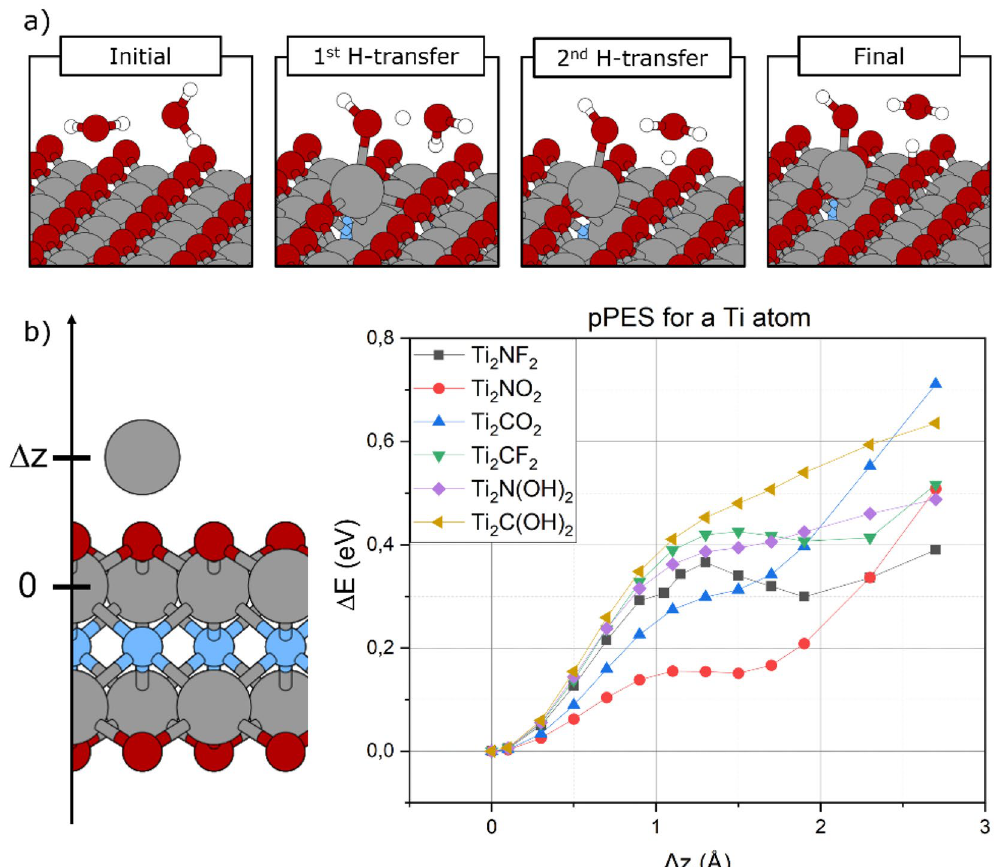
Fig. 7 Relevant steps for the Ti 2 NO 2 degradation caused by the presence of water ( a ). Schematic explaining how the pPES calculations where performed and energy barriers related to the extraction of a Ti atom ( b